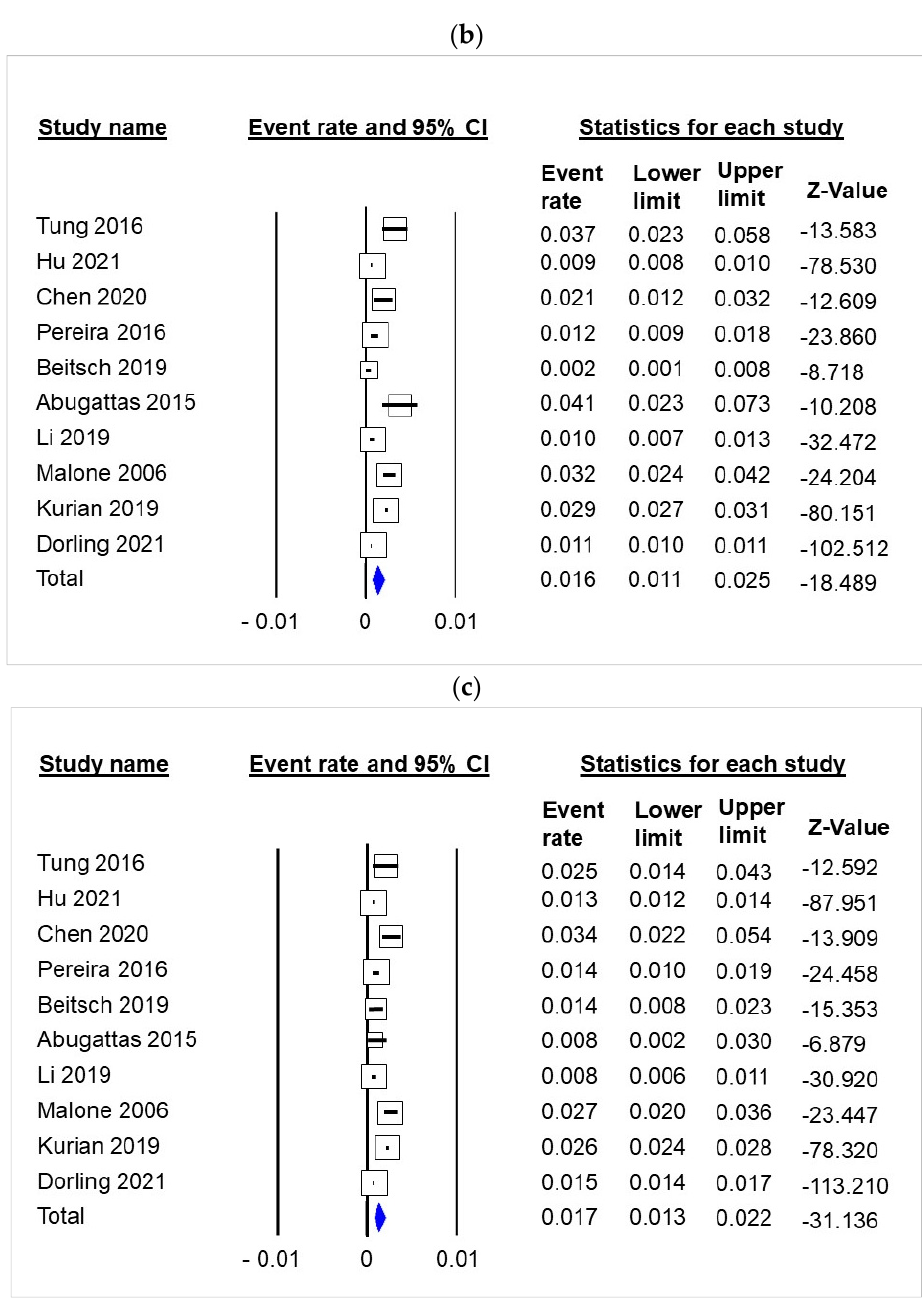
Figure 1. Meta-analysis of gBRCA1 and gBRCA2 among 108,699 unselected breast cancer patients. ( a ) gBRCA; ( b ) gBRCA1; ( c ) gBRCA2. ( a ) gBRCA; ( b ) gBRCA1; ( c ) gBRCA1 and gBRCA2 status accounted for 1.66% (95% CI 1.08–2.54) and 1.71% (95%